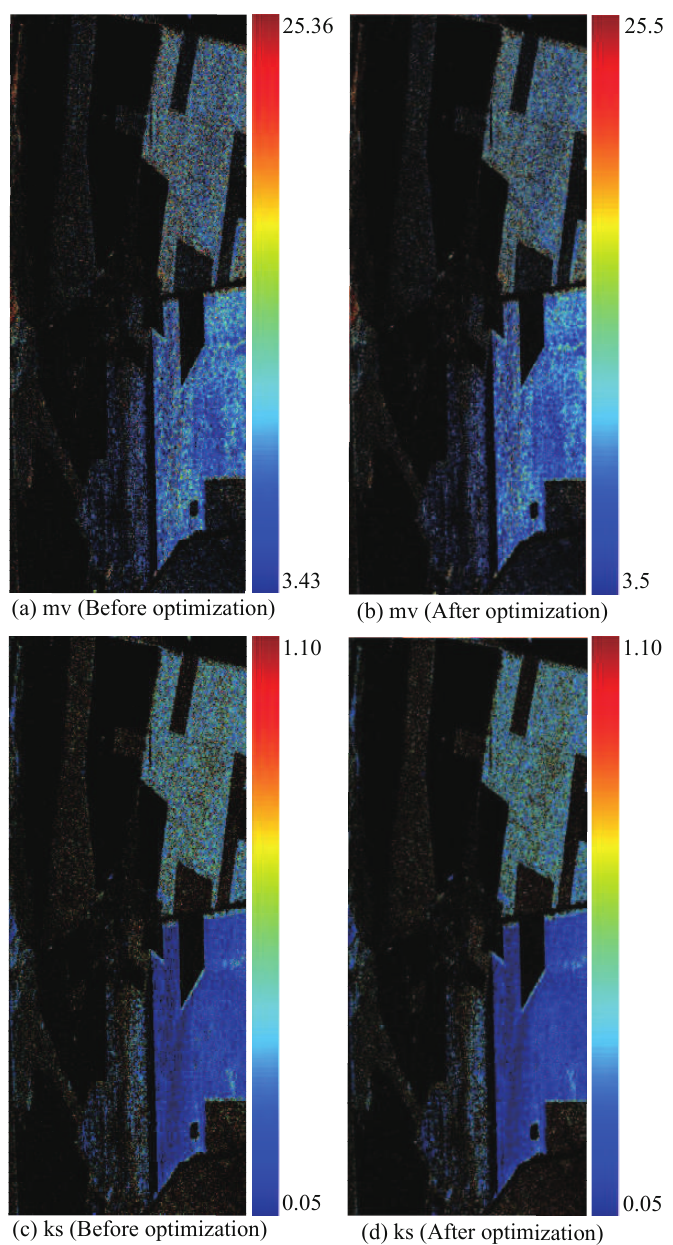
Figure 8. The soil parameter inversion comparison of sequential and parallel optimization Oh